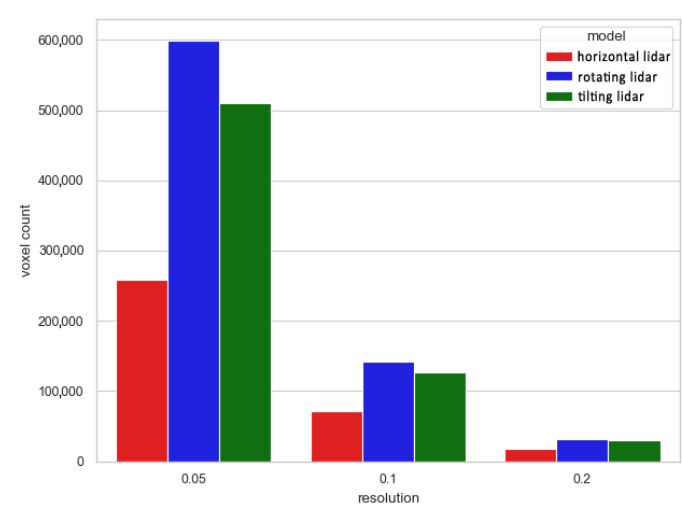
Figure 15. Number of voxels for different voxelgrid